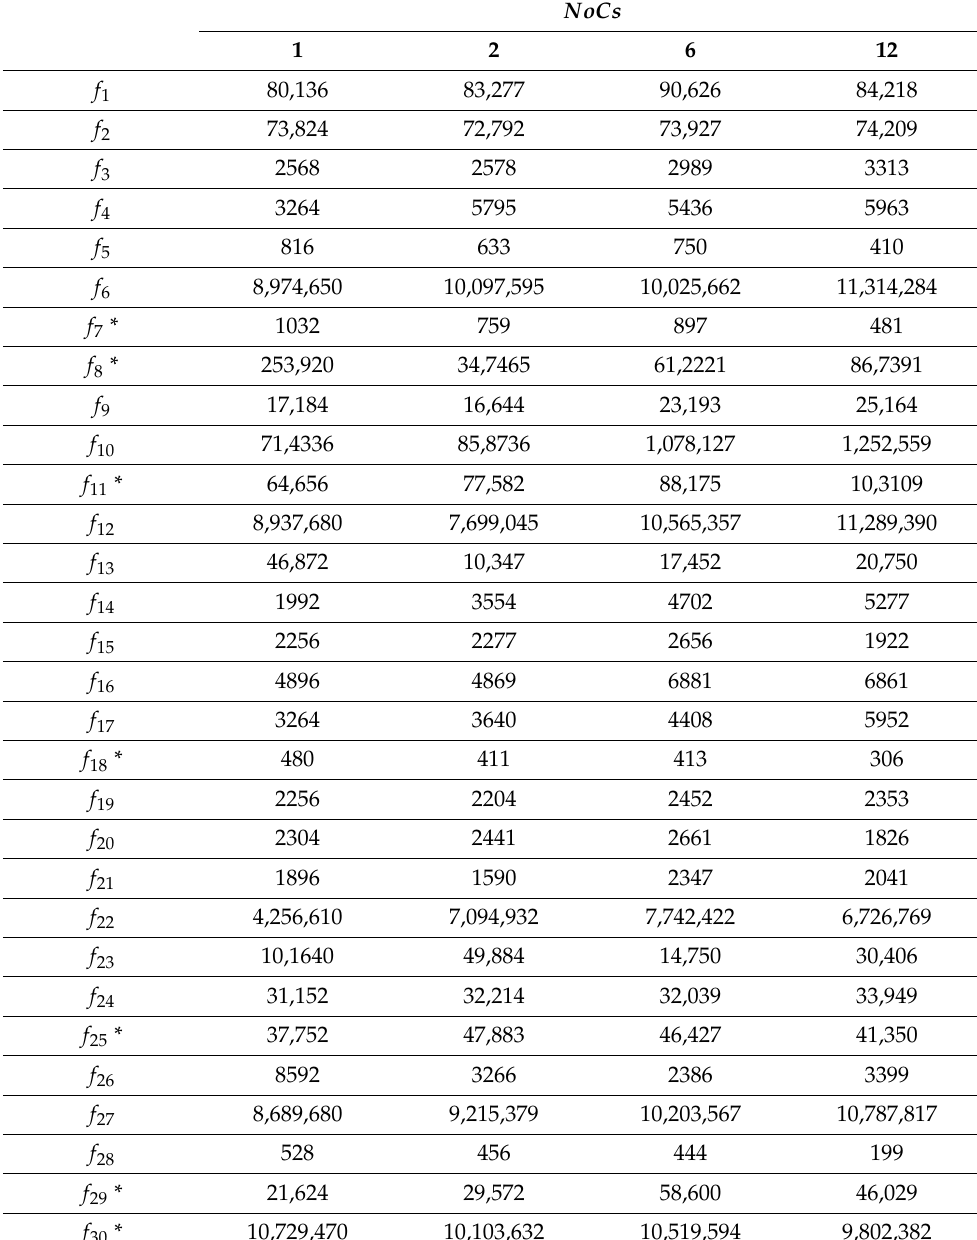
Table 11. Asynchronous parallel algorithm: number of function evaluations for error <1 × 10 − 3 (* < 1 × 10 2 ). popInitSize =